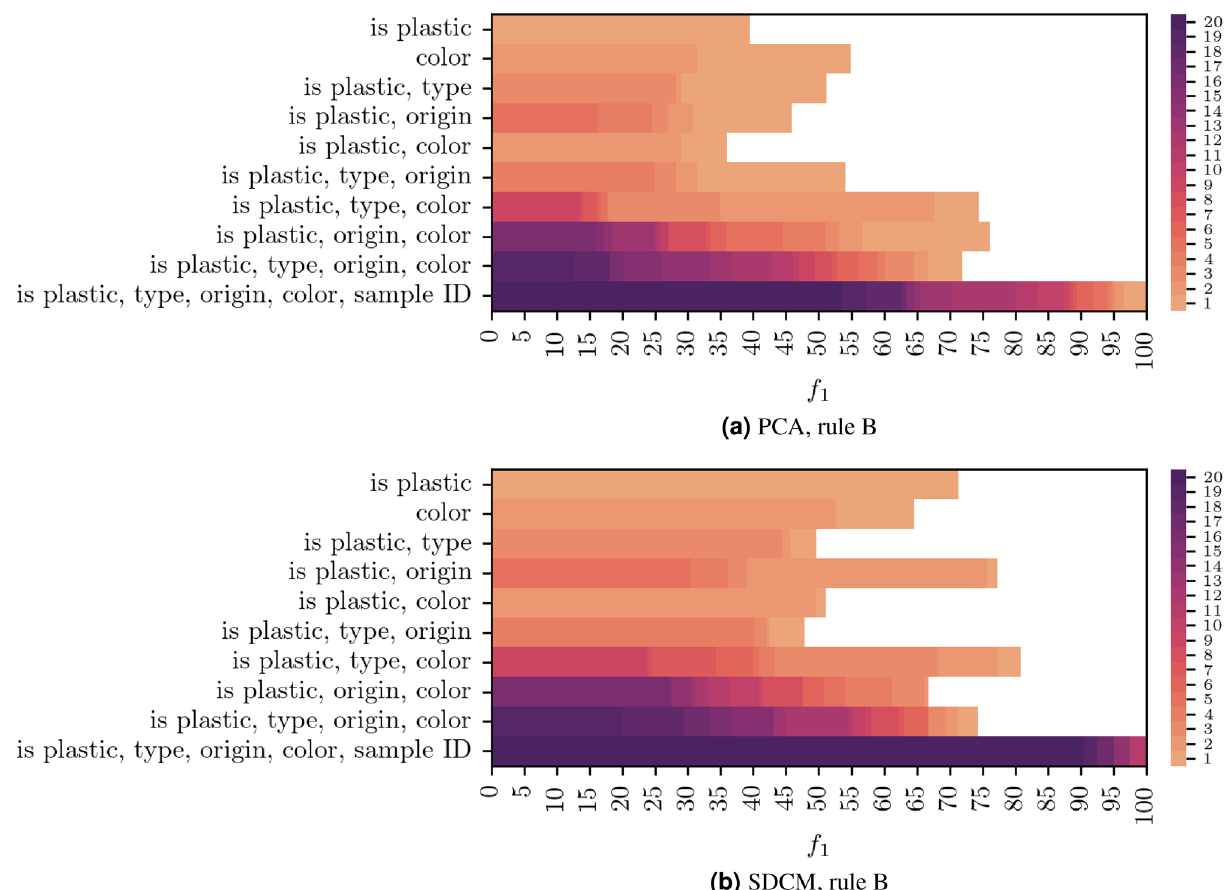
Figure 6. ( a ) PCA, rule B. ( b ) SDCM, rule B. Cumulative distributions of matched labels over f 1 in the categories defined by rule B. For each set of categories, which are defined by rule B, the figures show the number of labels that can be matched with at least one cluster at a given f 1 score or higher. The color scale is capped at 20 to improve